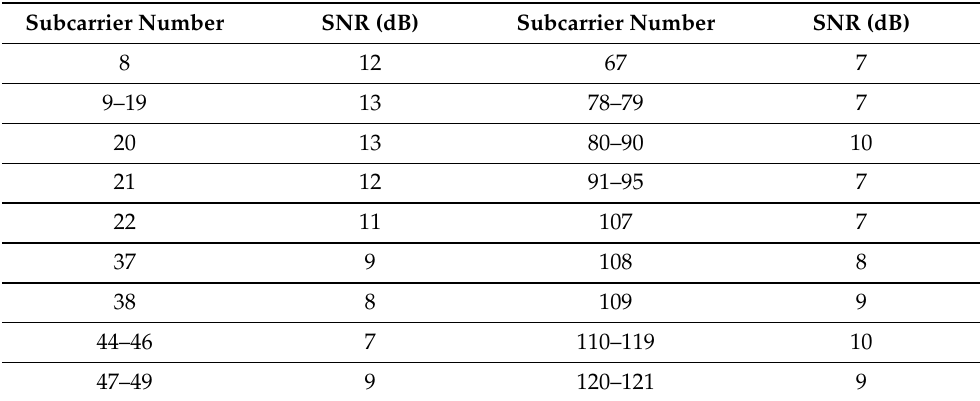
Table 3. SNR of data